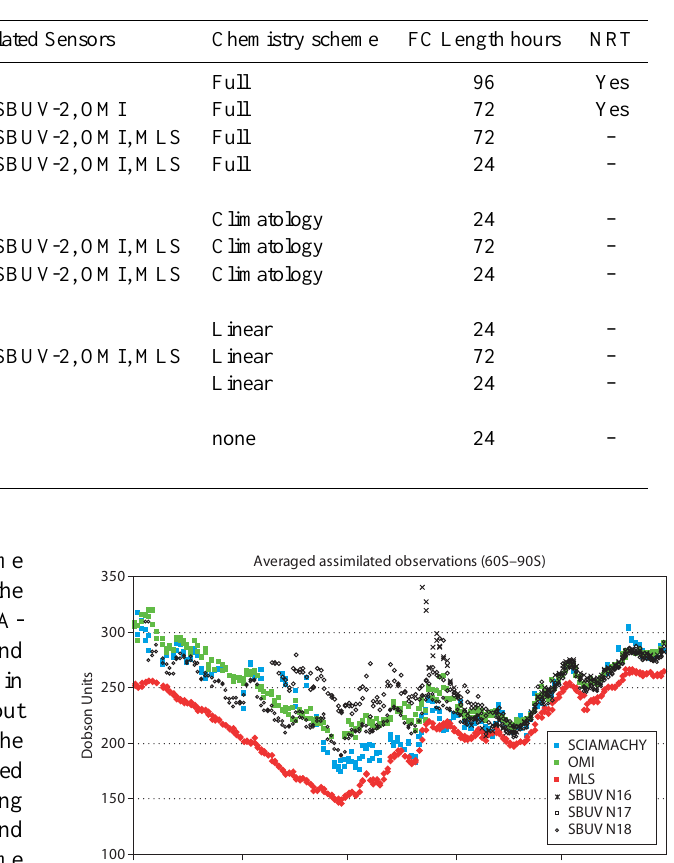
of IFS-MOZART for OMI, SCIAMACHY and MLS against latitude, averaged over one week at the end of August and the end of November. The analysis departures from the 16 par- tial MLS columns between 0.02 and 215 hPa (see Table 1) were symmetric and had nearly zero average at all latitudes between 60 ◦ S–90 ◦ S for all levels as a whole (see Fig. 3) and also for the individual levels (not shown). This means that the analysis was bias-free against this data set, which covered the stratosphere only, both at the end of August and November. At the end of August, OMI’s total column values had a bias of about 4 DU against the analysis with the highest bias occur- ring at lower solar elevation (not shown). The SCIAMACHY total columns were on average bias free but showed small negative biases at higher solar elevation at the end of